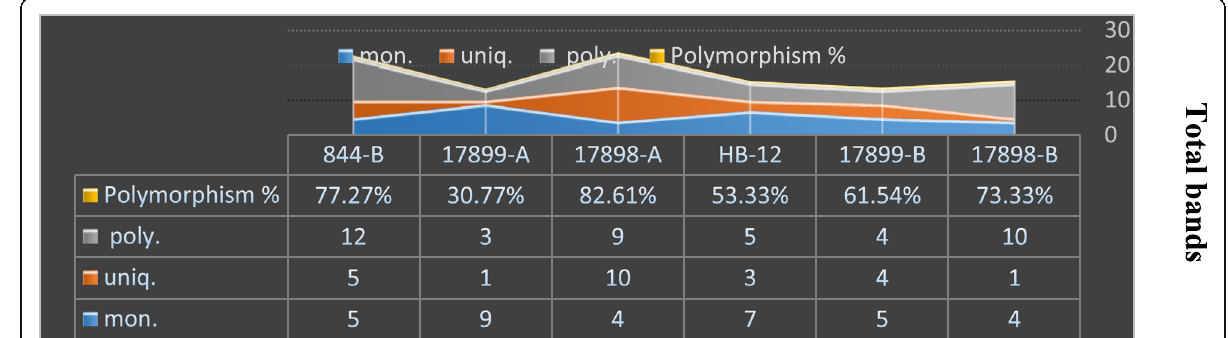
Fig. 2 The relationship between total bands and monomorphic, unique, polymorphic, and polymorphism percentage of six ISSR primers used for detection of seven rice lines